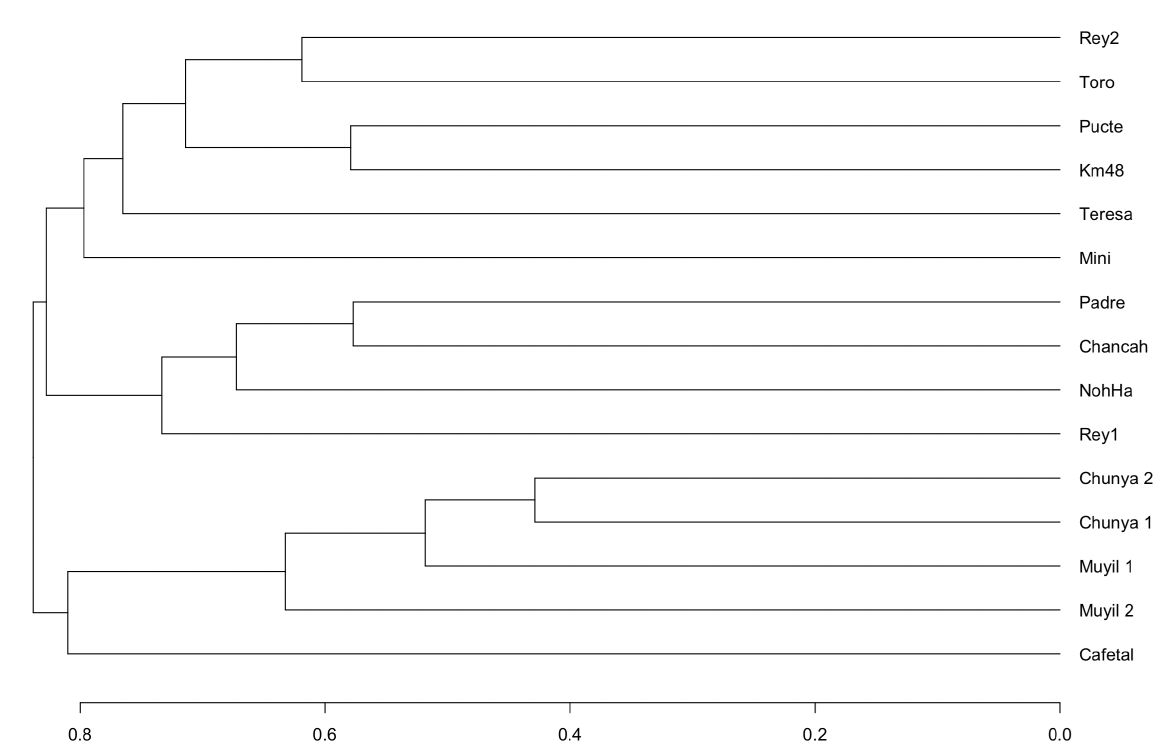
Figure 7. Similarity dendrogram of the localities sampled. Abbreviations: Tres Reyes sinkhole 2, Rey2; Chunyaxché 2, Chunya 2; Pucté 2 sinkhole, Pucté; Chancah Veracruz, Chancah; Santa Teresa sinkhole, Teresa; Laguna Muyil 1, Muyil 1; Pucté Cafetal sinkhole, Cafetal; Tres Reyes sinkhole 1, Rey1; Minicenote sinkhole, Mini; Sijil Noh Há sinkhole, NohHa; Chunyaxché 1, Chunya1; Km 48, Km48; El Toro sinkhole, Toro; Laguna Muyil 2, Muyil 2.